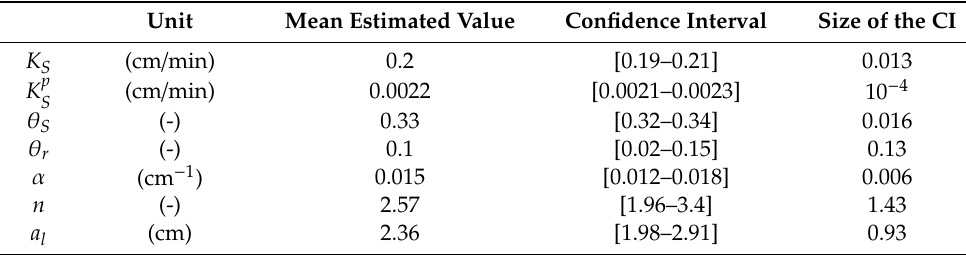
Table 2. Estimated mean values, confidence intervals (CIs), and size of the posterior CIs for the linear transport model.